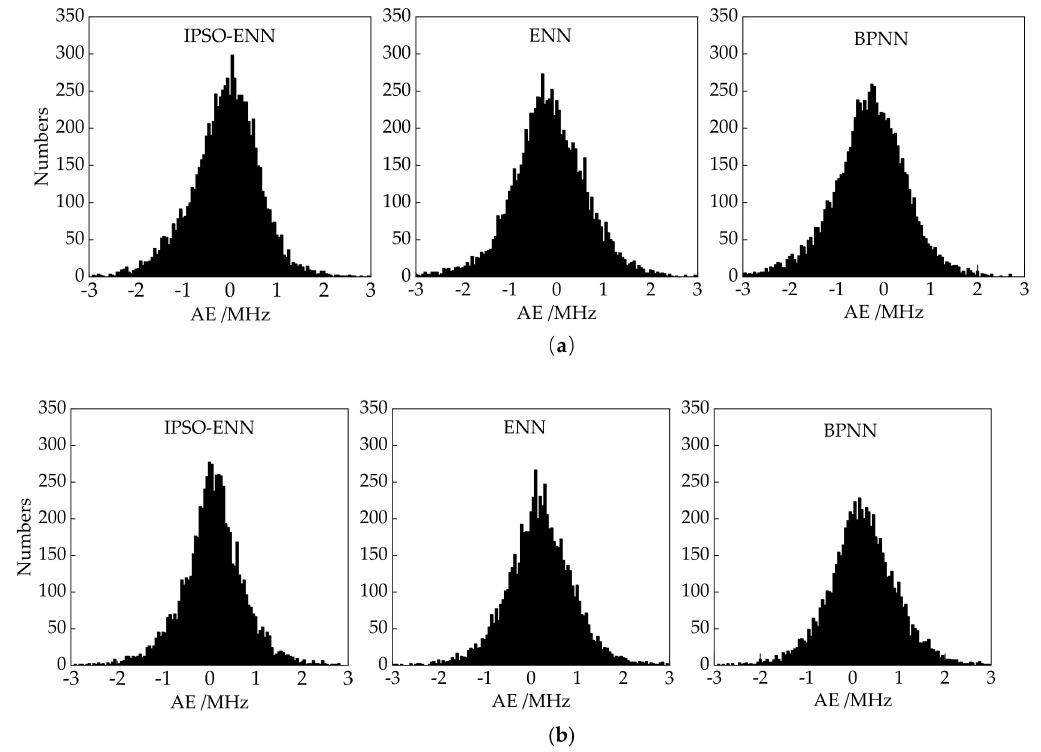
Figure 4. The comparison of absolute error (AE) histograms. ( a ) AE histograms of the three models in 2014; ( b ) AE histograms of the three models in